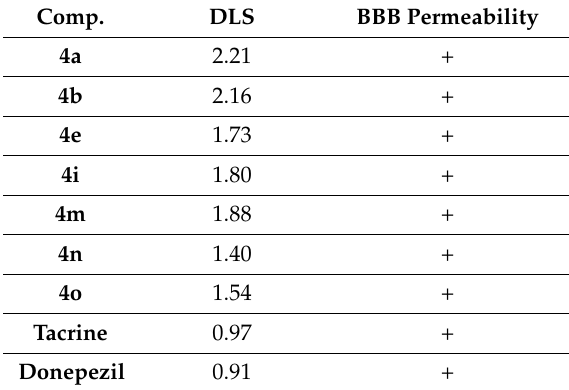
Table 3. Drug-likeness score (DLS) and blood–brain barrier (BBB) permeability of the active